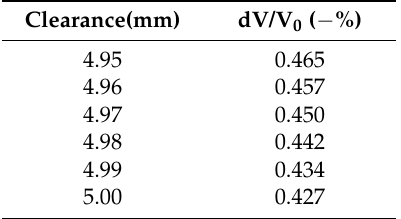
Figure 7. Calibration curve at room temperature. Table 1. Calibration data at near full range area.